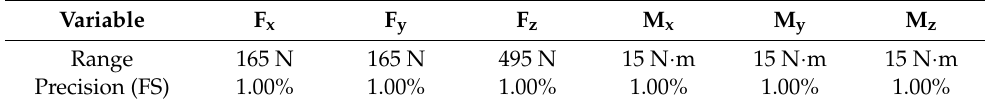
Table 2. Measuring range and accuracy of each measuring axis of ATI balance.